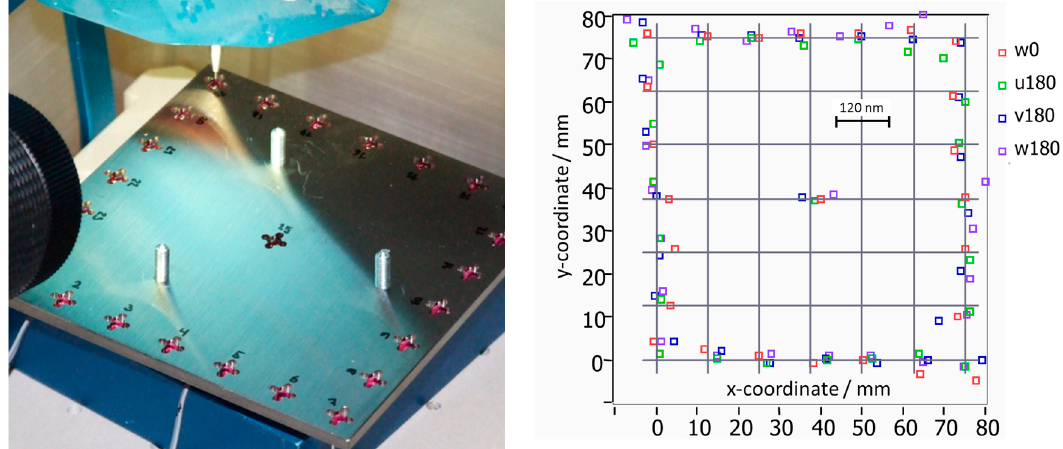
Figure 8. ( left ) Micro ball plate used for performance verification; ( right ) Deviations measured for 25 ball center positions in four different orientations of the ball plates. The evaluation of all relative ball distances results in a 95% confidence length measurement error of E 0 = 26 nm + 0.23 × 10 − 6 × L .